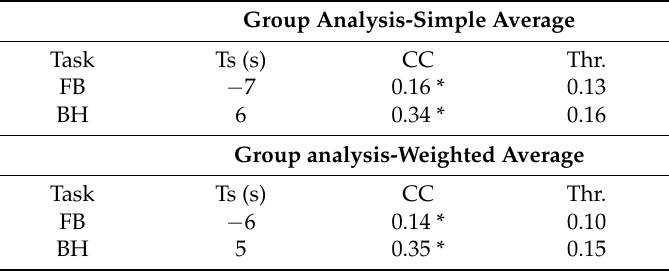
Table 6. Correlation analysis results at group level between GFP estimated in delta band and P ET CO 2 . The time shift with maximum correlation coefficient (Ts), the corresponding correlation coefficient (CC), and the critical values (Thr.) corresponding to α = 0.05 are